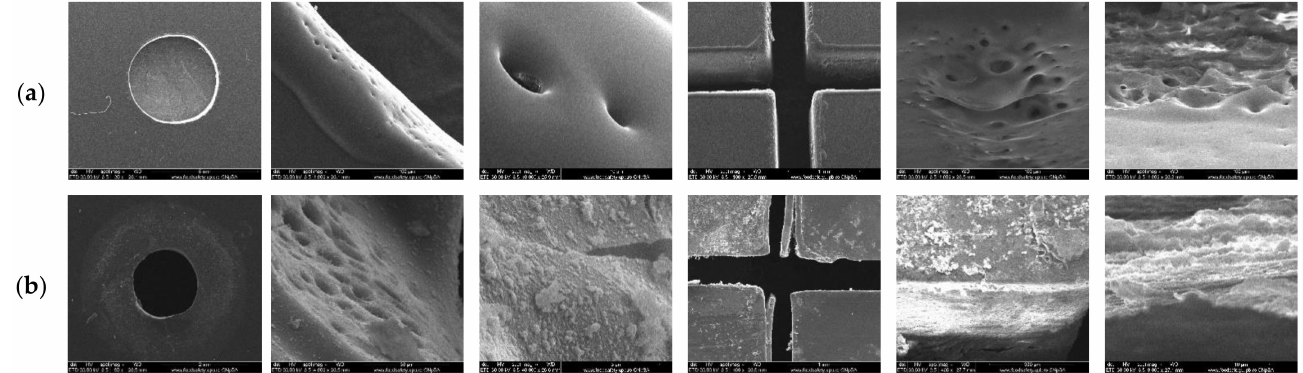
Figure 3. SEM images of the outlet and the cross-junction area of the microchannel before ( a ) and after ( b )